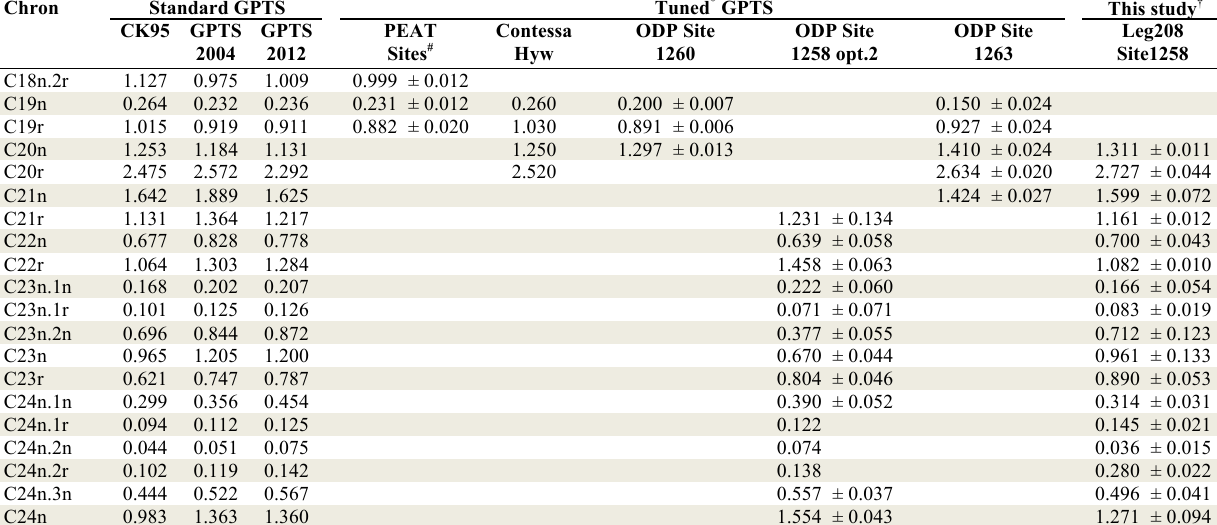
Table 2. Comparison of magnetochron boundary durations in millions of years. Chron S tandard GPTS T uned *